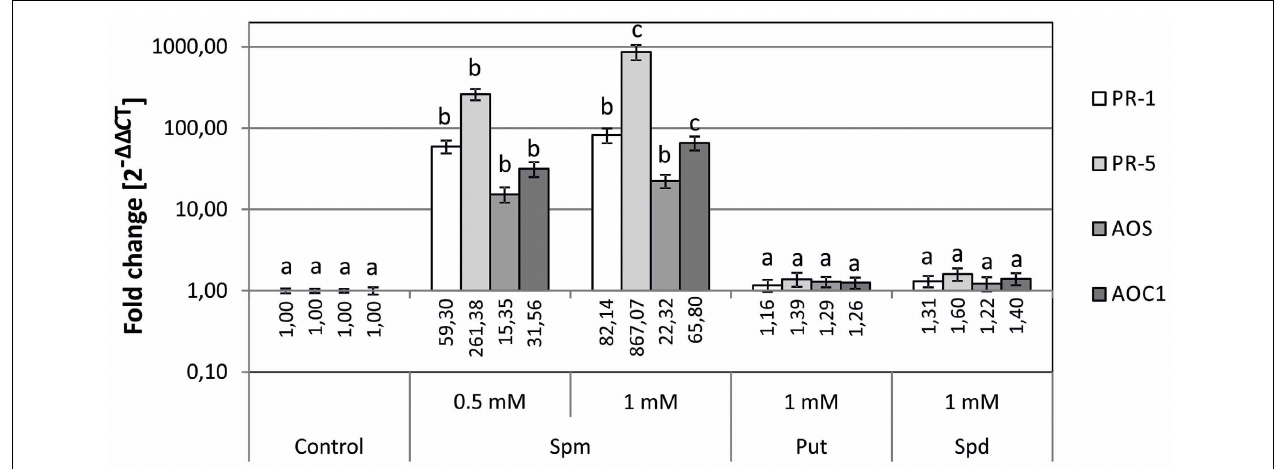
FIGURE 2 | Effects of external polyamine treatment on the expression of biotic stress defense-related genes ( PR-1 and PR5 ) and jasmonate biosynthesis genes ( AOS and AOC1 ). Plants were grown for 5 days in plates supplemented with Put, Spd, or Spm, as well as in control plates without the amendment of PAs. Expression levels were determined by